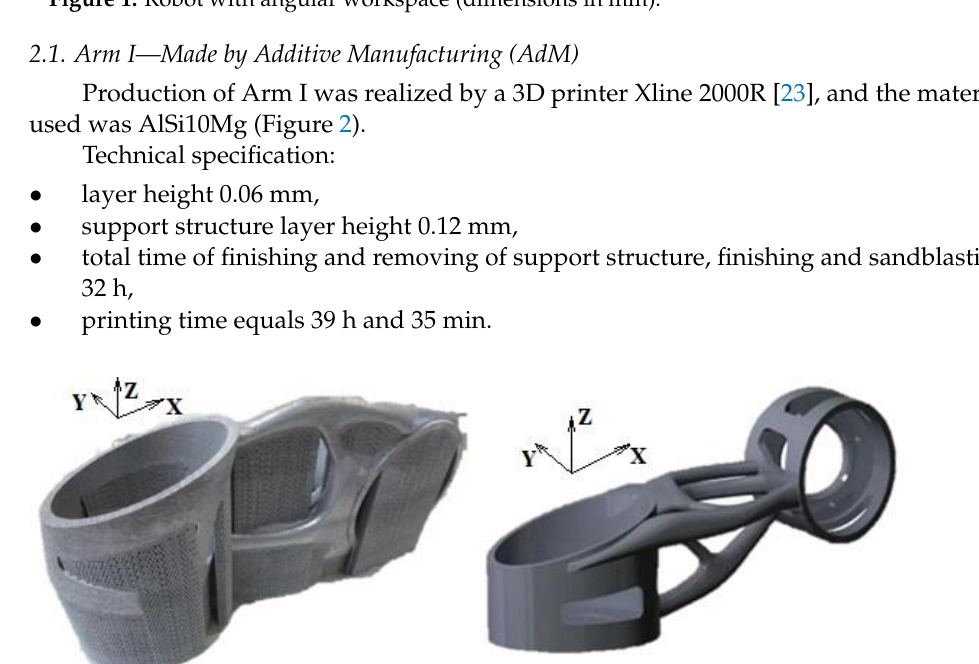
Figure 2. Arm I — additive manufacturing (AdM) made on 3D printer Xline 2000R.